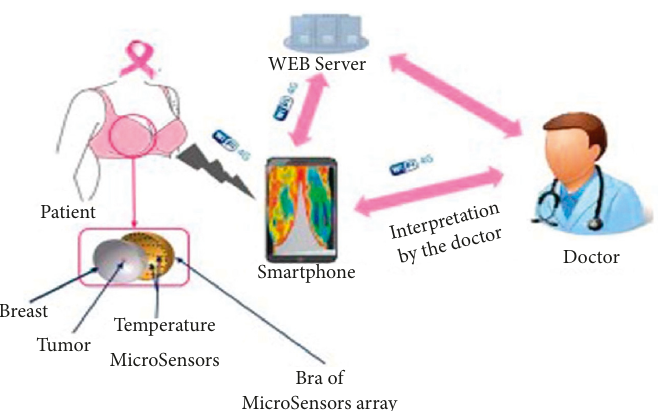
Figure 1: Proper detection of breast cancer steps via IoT methods